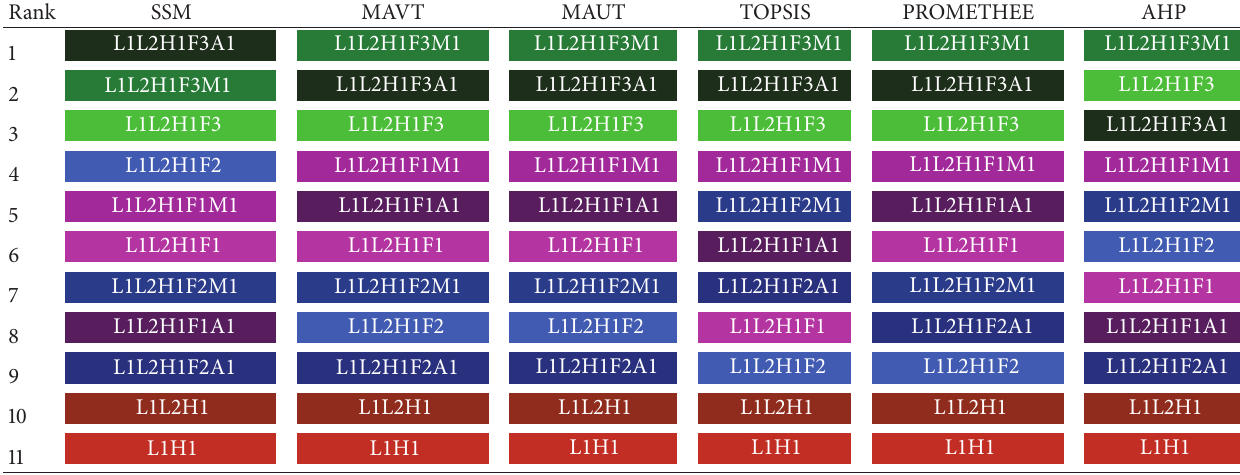
Table 5: Comparative analysis of ranking results by different methods (for weight variant number 1).